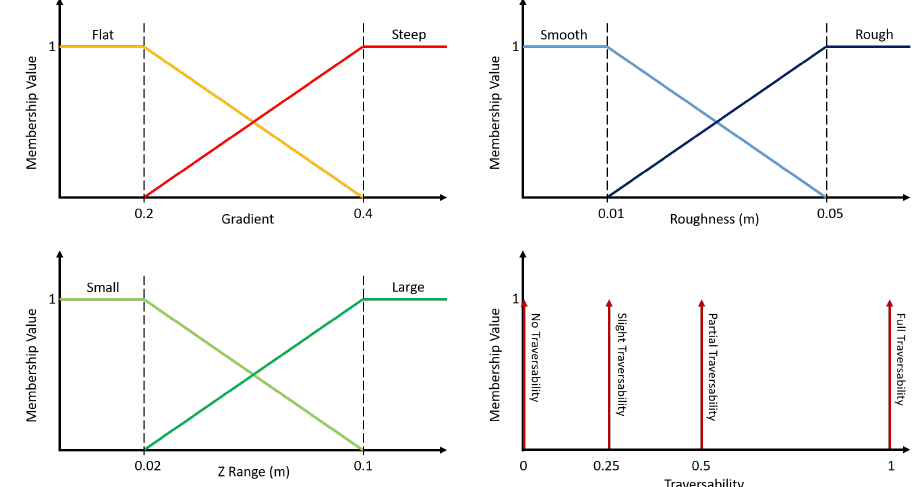
Figure 8. Membership functions for fuzzy sets that describe gradient, roughness, height range and